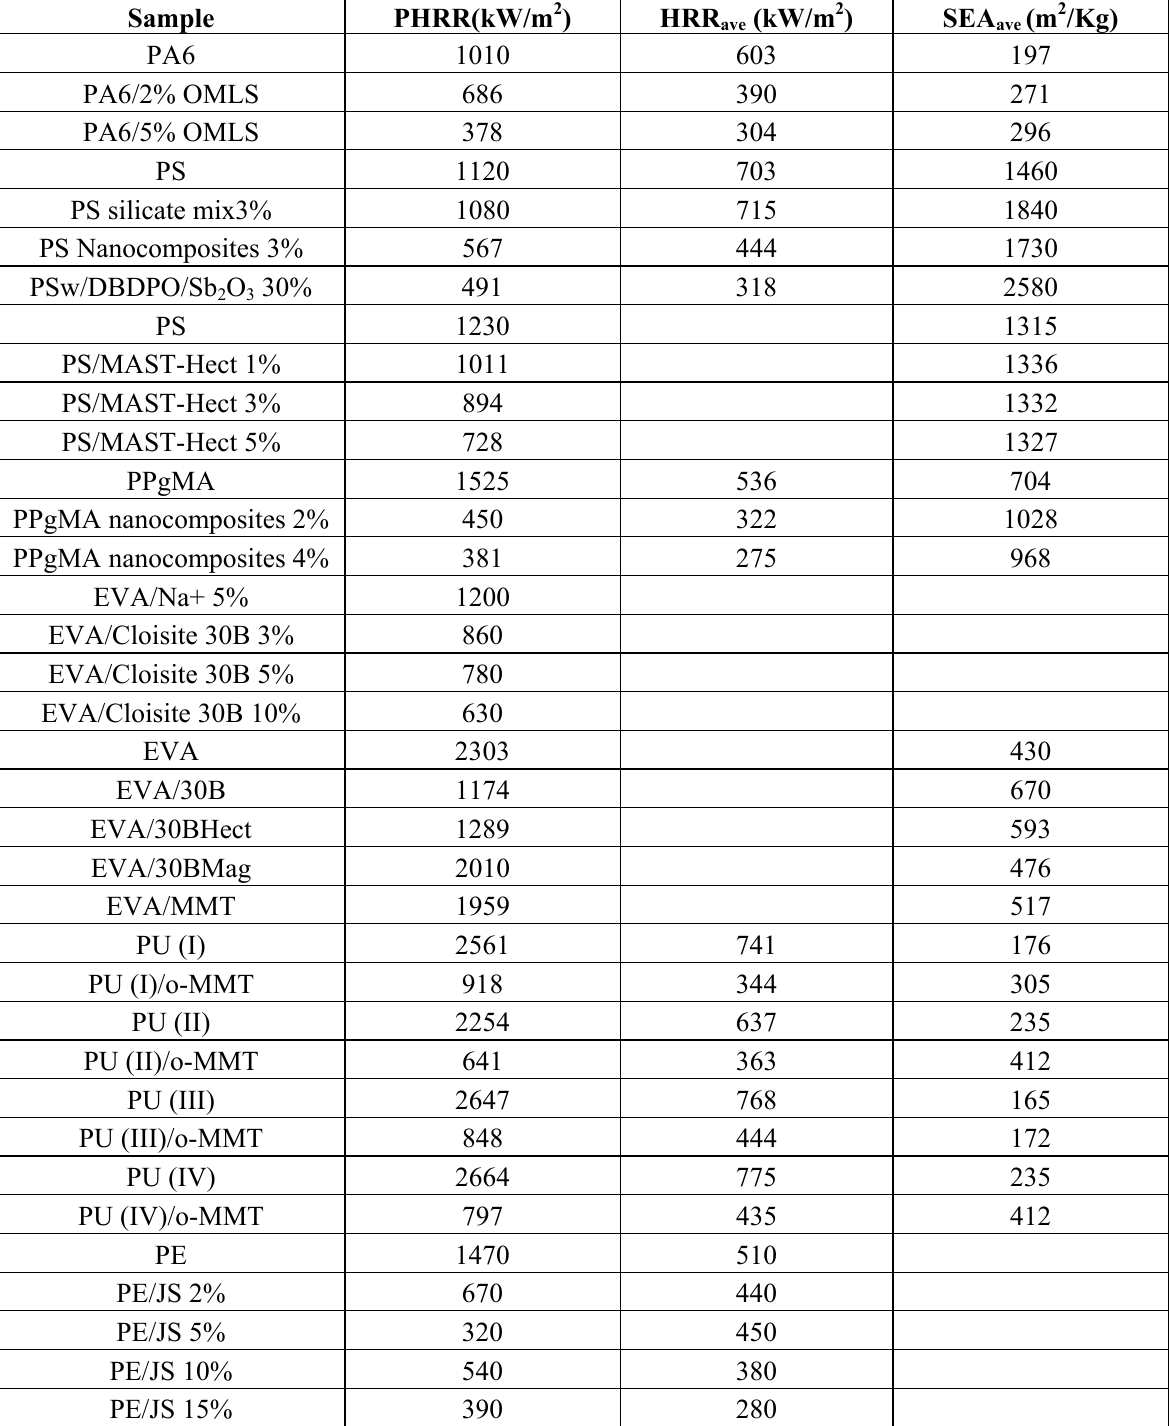
Table 5. Cone calorimetric data of various polymer nanocomposite systems. Reproduced from reference [4] with permission from